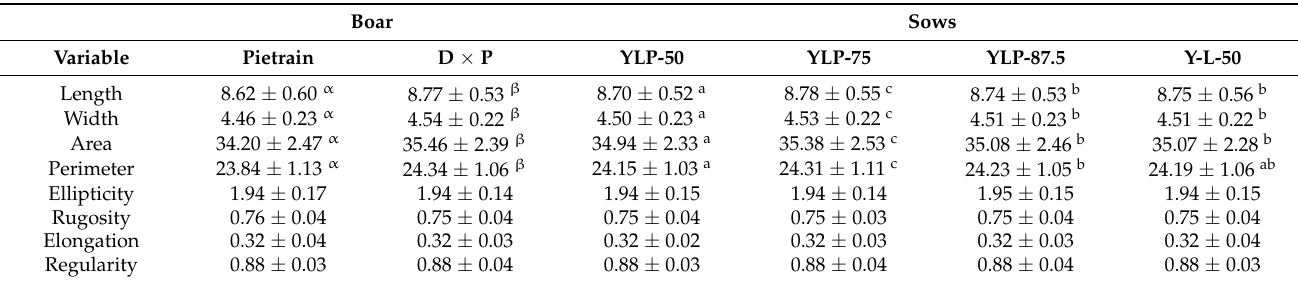
Figure 1. Box and whisker plot of distribution of boar sperm head size morphometric variables. Each box contains the central 50% of the observations and the whisker contains the central 95%. a–f Boxes labelled with different letters indicate differences between boars. p < 0.05. Table 1. Morphometric variables (mean ± s.d.) of boar sperm size and head shape of in different crossbred males and AI doses use in